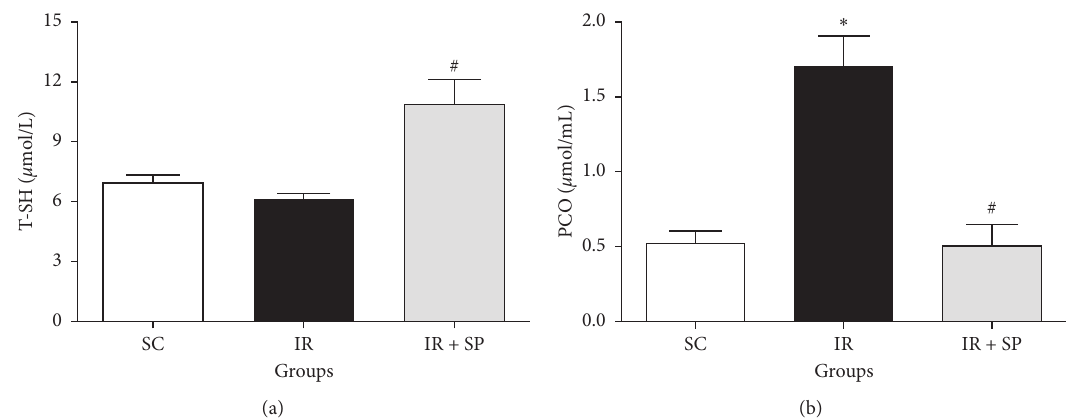
Figure 3: Effect of SP extract on T-SH (a) and PCO (b) following I/R injury. Data are shown as mean ± SEM. ∗ Significant against the SC rats ( P < 0 . 05); # significant against the IR group ( P < 0 . 05). SC: sham control; SP : Stachys pilifera ; I/R: ischemia-reperfusion; T-SH: total thiol; PCO: protein carbonyl.